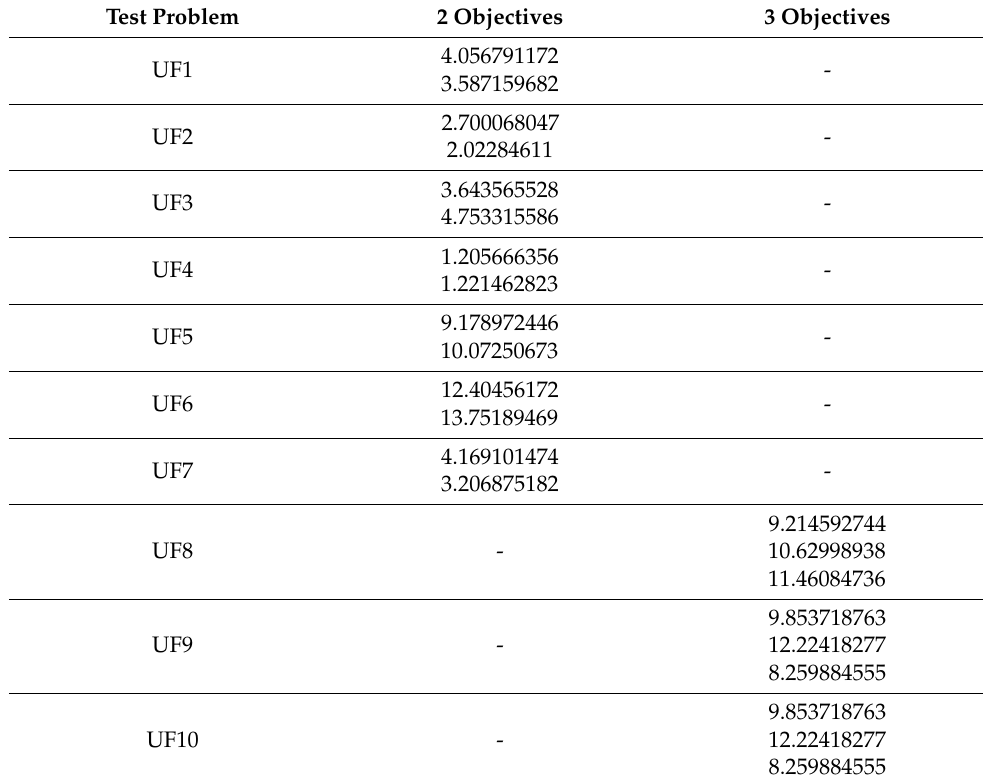
Table 5. Reference points for CEC2009 problems used by HV